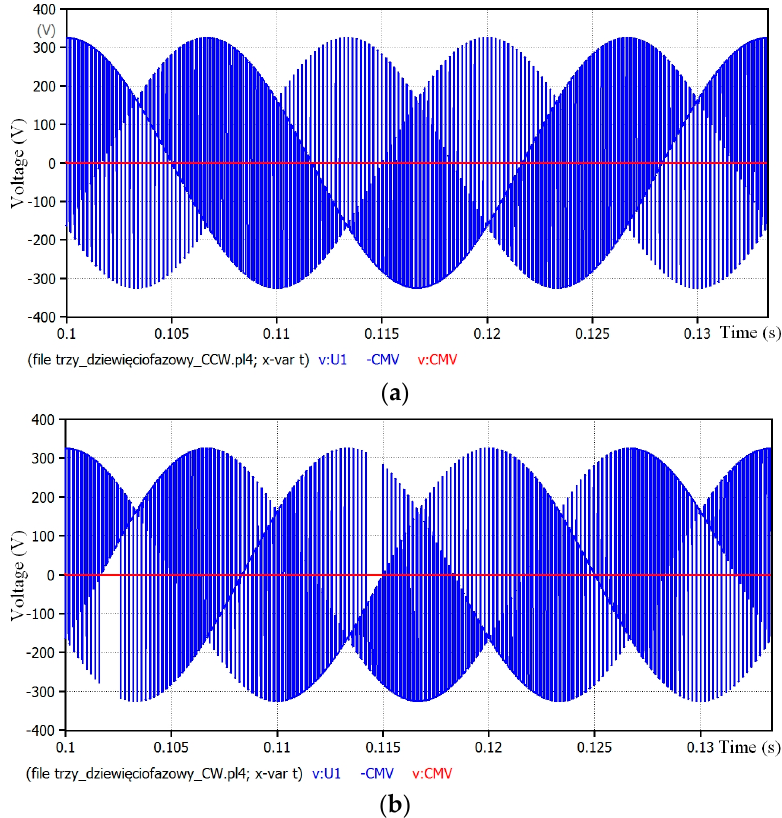
Figure 9. Waveforms of the phase output voltage (blue lines) and the CMV (red line) for ( a ) CCW method and ( b ) CW method. Simulation performed for the output frequency f o = 30 Hz.